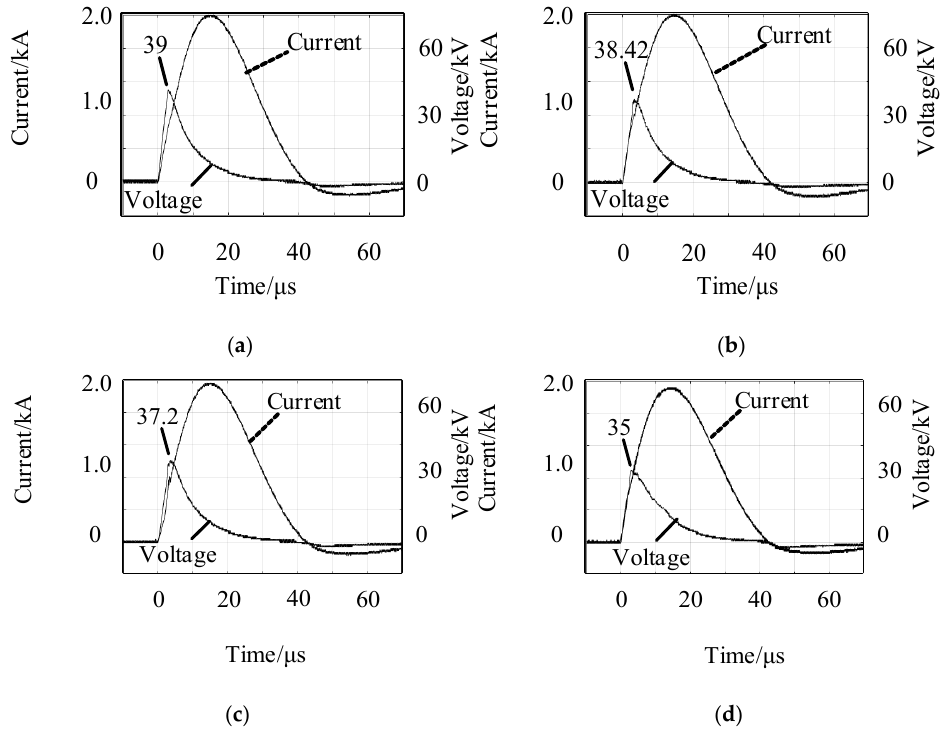
Figure 4. Current and voltage waveform of soil with the same resistivity and different water content: ( a ) The moisture is 23.56%; ( b ) moisture is 39.14%; ( c ) moisture is 40.50%; ( d ) moisture is 48.80%. Table 1. V I and R ch2 of soil with the same resistivity that is 50 Ω ·m and different water content.